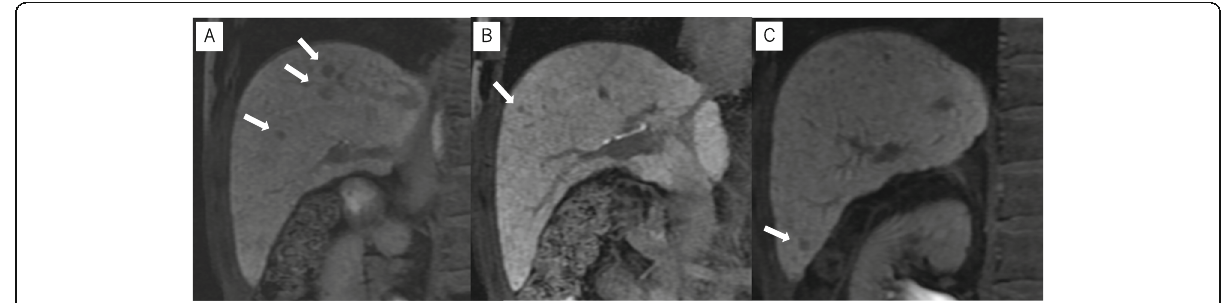
Fig. 2 a – c Magnetic resonance imaging revealed low nodular shadows in the liver cell phase in the anterior segment and